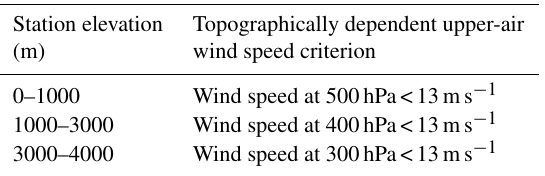
Table 1. Station elevations and the corresponding upper-air wind speed